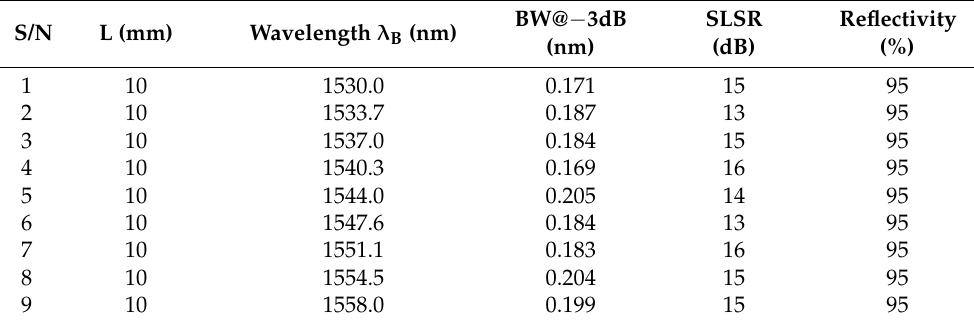
Table 1. Typical specifications of the FBG sensors used for experiments.